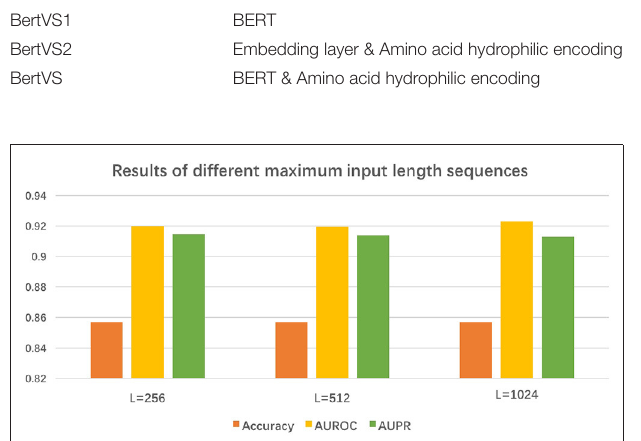
FIGURE 4 | Results of BertVS with varying size of